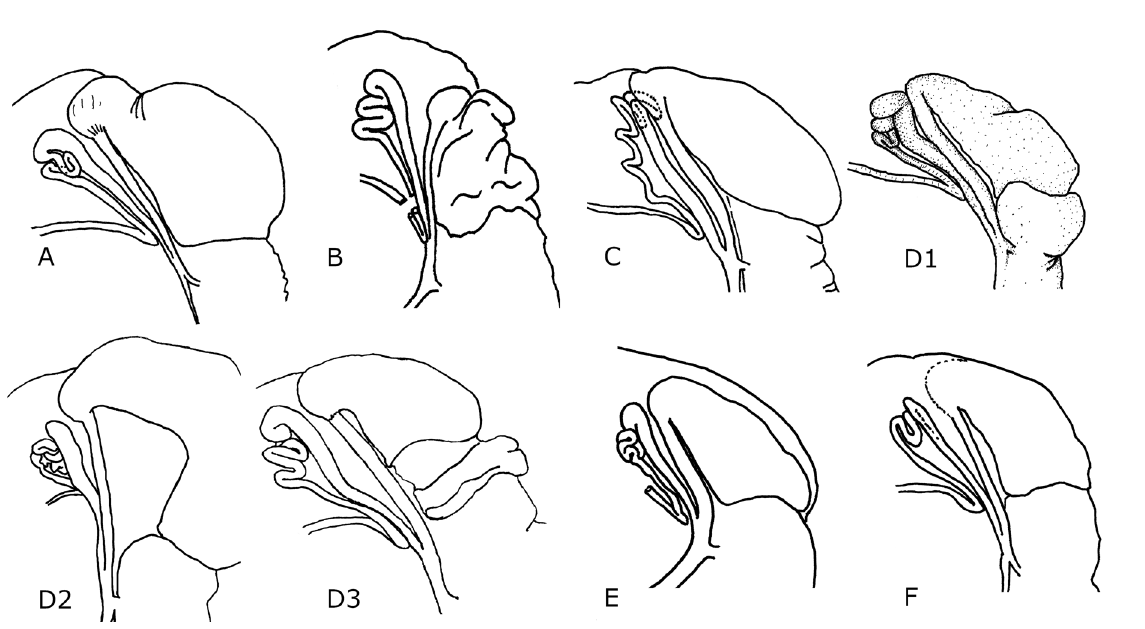
Fig. 18. Variation of the female genitalia in Cochlostoma ( Clessiniella ) villae (Strobel, 1851). D3 . Perarolo, Italy (EZ0891). E . Mt Rusta, Italy (EZ0894). F . Ca’ Gottolo, Italy